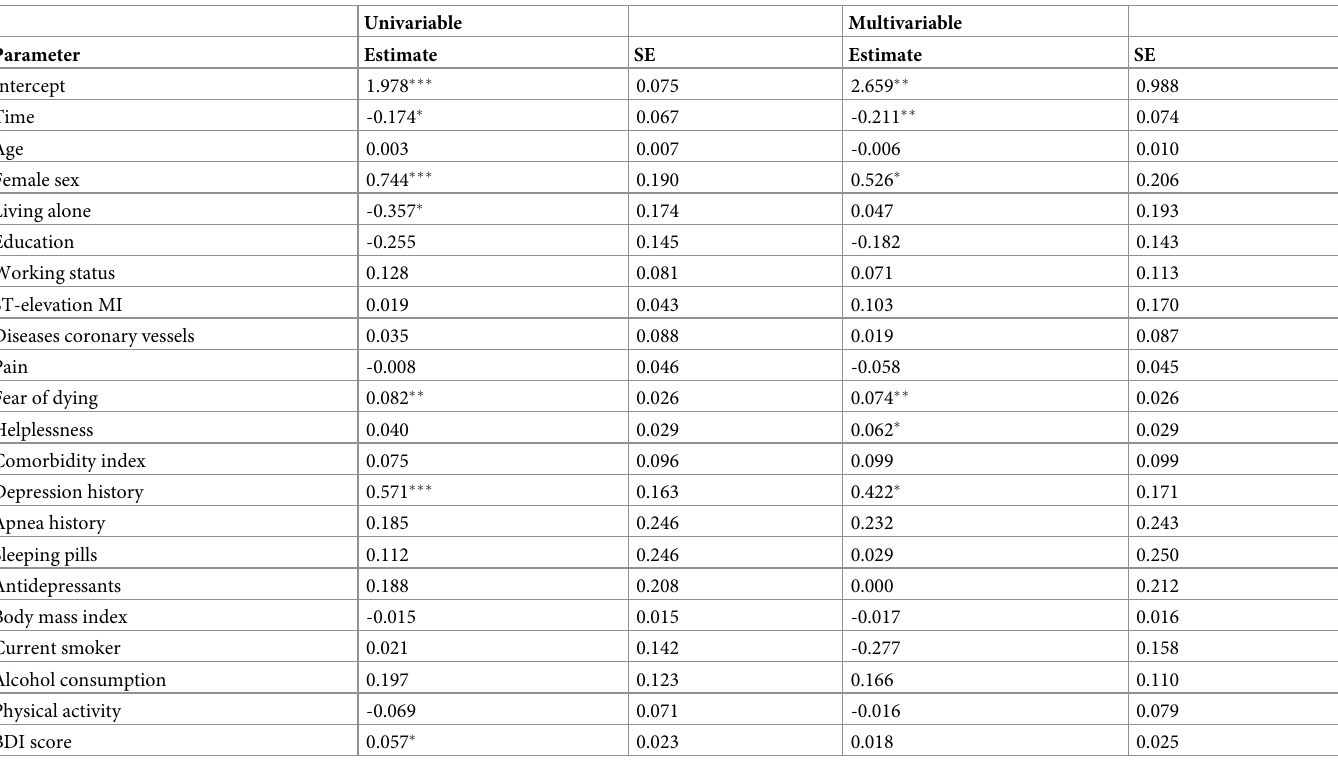
Table 2. Univariable and multivariable relations with sleep disturbance over 12